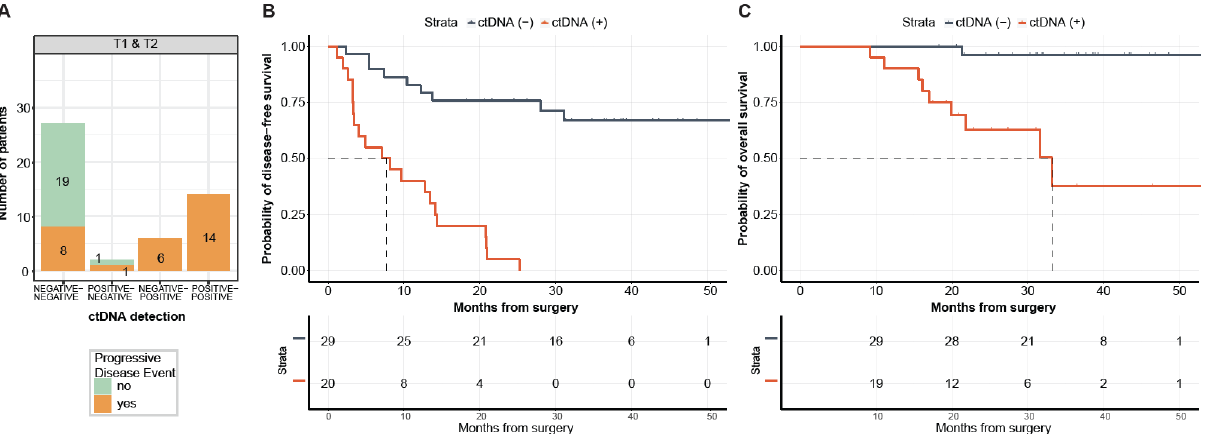
Figure 6. ( A ) ctDNA detection rates across two time points (T1 + T2). ( B , C ) Kaplan–Meier estimates for 49 patients monitored by FoundationOne ® Tracker across two time points (T1 + T2) stratified by ctDNA detection at the last or follow-up time point (T2).